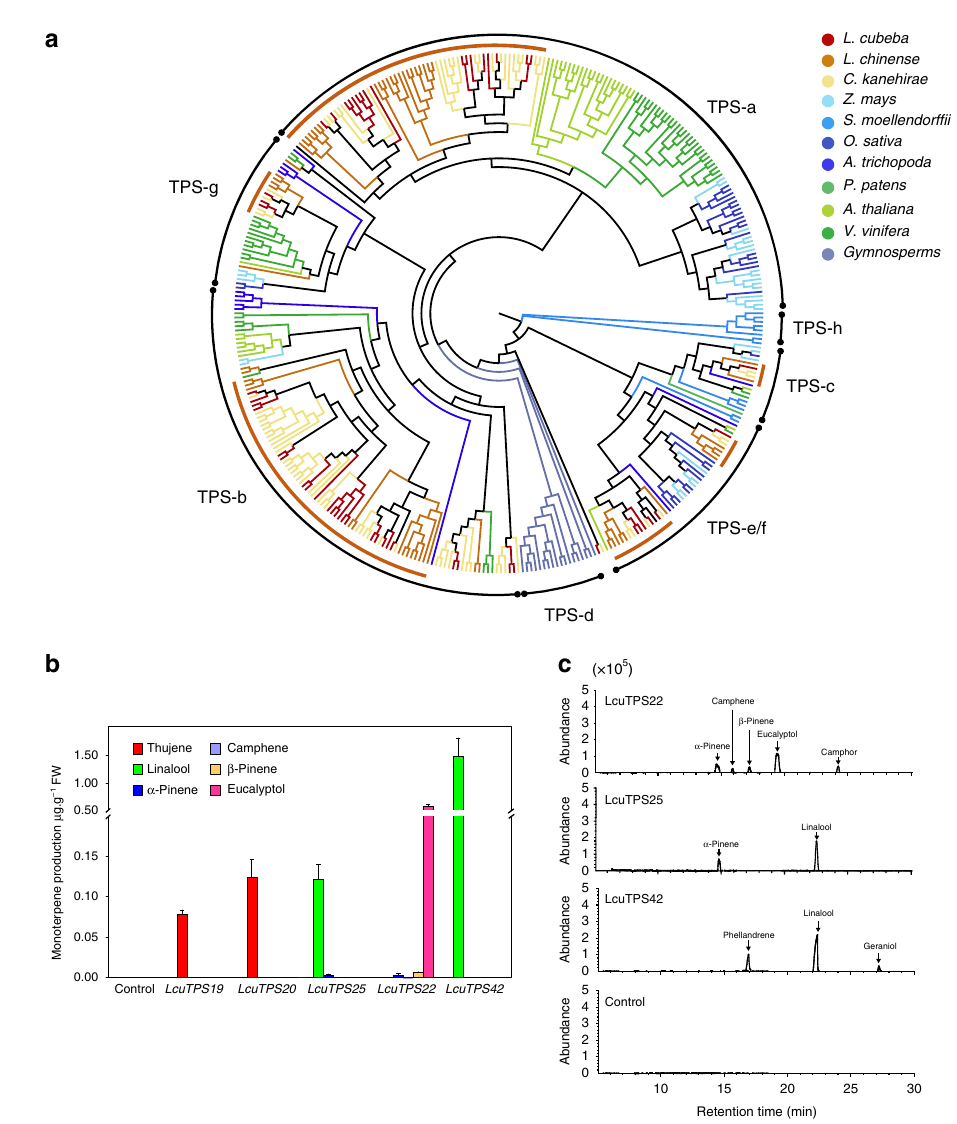
Fig. 5 Phylogeny and functional veri fi cation of LcuTPSs. a Phylogeny of TPSs. Putative full-length TPS proteins (>200 amino acids in length) identi fi ed in L. cubeba (Supplementary Table 32) and 10 other sequenced plant genomes (Supplementary Table 33) were subjected to phylogenetic analysis. TPS subfamilies are shown along the circumference of the circle. b Transient overexpression of LcuTPSs in Nicotiana benthamiana leaves. After in fi ltration, the plants were grown for 2 days and the presence or concentration of the monoterpenes was detected using GC-MS analysis. Data represent the mean ± SDs of three biological replicates. c Identi fi cation of enzymatic products after incubating recombinant LcuTPSs proteins with geranyl diphosphate. The recombined enzyme expressed in Escherichia coli was puri fi ed by Ni 2 + af fi nity. The volatile terpenes were further analyzed by GC-MS analysis comparison with authentic standards (Supplementary Fig. 18). Source data underling a , b are provided as a Source Data fi Methods the longest 60× coverage of subreads were selected as seeds to do error correction Sample preparation and sequencing . For genome sequencing, we collected tis- with parameters “ --output_multi --min_idt 0.70 --min_cov 4 -- max_n_read 300. ” The corrected reads were then aligned to each other to construct string graphs with sues from L. cubeba in Zhejiang Province (Supplementary Note 1), China, with a parameters “ --length_cutoff_pr 11000. ” The graph was further fl ited with para- karyotype of 2 n = 24 and with uniform and small chromosomes (Supplementary Fig. 2a). Genomic DNA was isolated from the buds of L. cubeba , and at least 10 μ g of sheared DNA was taken. SMRTbell template preparation involved DNA con- centration, damage repair, end repair, ligation of hairpin adapters, and template puri fi cation, undertaken using AMPure PB Magnetic Beads (Paci fi c Biosciences). Finally, we carried out 20kb single-molecule real-time DNA sequencing using PacBio to sequence a DNA library on the PacBio Sequel platform, yielding ~213Gb PacBio data (read quality ≥ 0.80 and mean read length ≥ 7kb) (Supplementary Table 1). for the assembly. The removal of genome hybrids was achieved by a purge of haplotigs, which provided a pipeline to the reassignment of allelic contigs 47 . Brie fl y, Genome assembly and assessment . The assembly of L. cubeba genome was the pipeline fi rst identi fi ed putative heterozygous contigs through read-depth analysis. Contigs with a high proportion of bases within the 0.5× read-depth peak conducted using PacBio and 10× Genomics Linked-Reads. De novo assembly of the were assigned as putative heterozygous contigs. These putative heterozygous PacBio reads was performed using FALCON (https://github.com/ contigs were then subject to a sequence alignment to identify its allelic companion Paci fi cBiosciences/FALCON/) with single-molecule, real-time sequencing. Brie fl y,